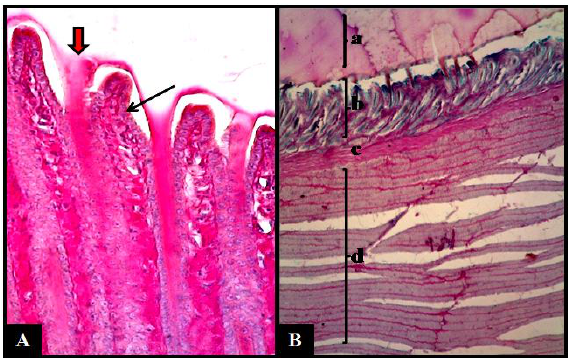
Fig. 7. A. Ventriculus wall cuticle (red arrow) and epithelial lining of the mucosa black arrow), (PAS, X 400). B. Ventriculus wall showed cuticle (a), mucosa (b), submucosa (c) and muscularis (d), neutral (purple color) and acid mucin (blue color), [AB-PAS (pH 2.5),